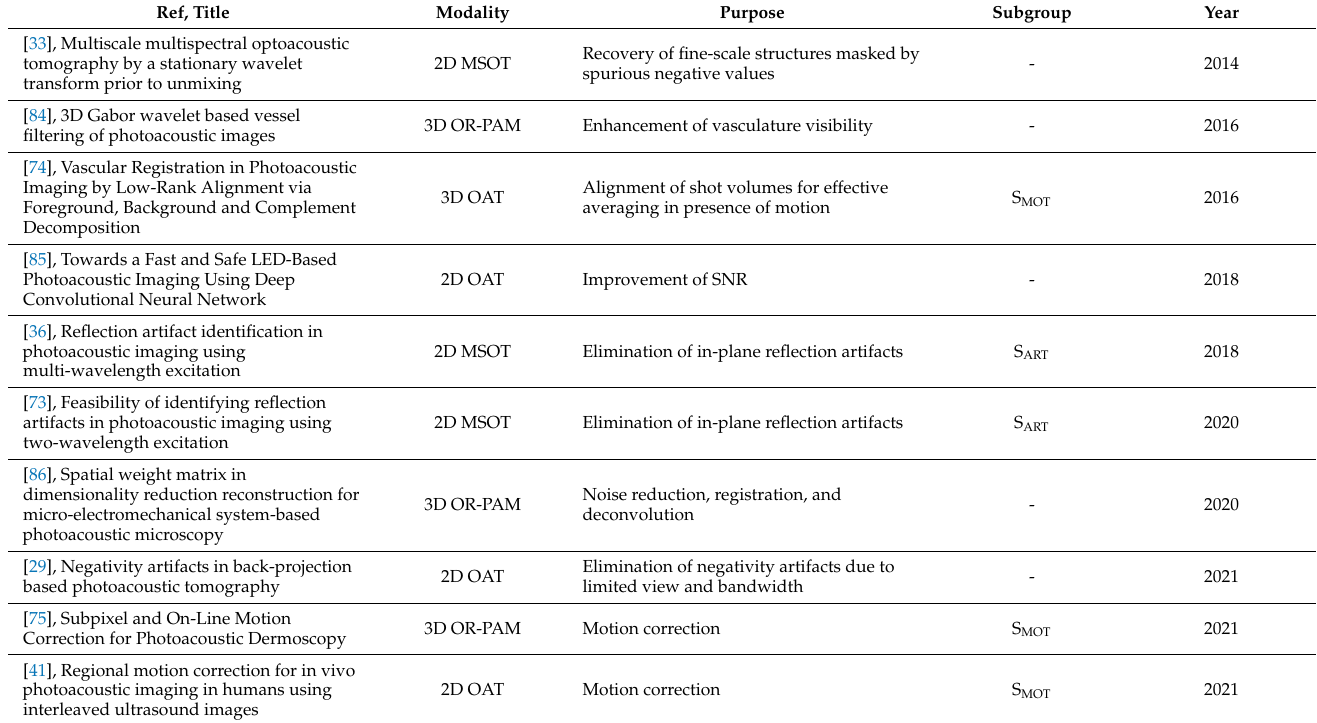
Table 5. Summary of the identified image domain (post-processing) approaches. OAT: optoacoustic tomography, MSOT: multispectral optoacoustic tomography, OR-PAM: optical-resolution photoa- coustic microscopy, RSOM: raster-scan optoacoustic